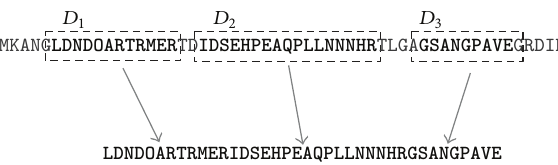
Figure2:Illustrationofrestrictinganaminoacidsequencetowhich the spectrum kernel is applied to the domain